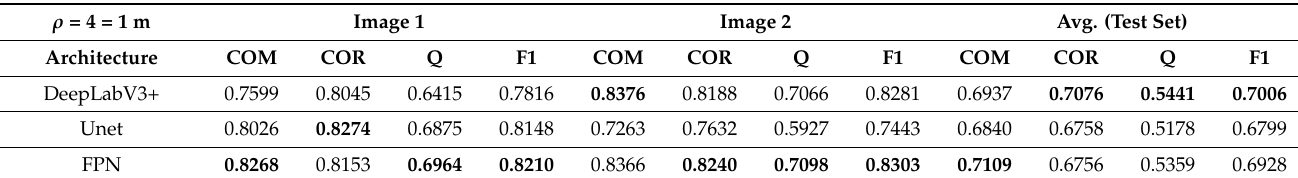
Table 3. Rural road extraction quantitative results for a ρ = 4 (using the Zhang–Suen thinning algorithm)—values in bold represent the road detection algorithm with the best performance in each parameter.